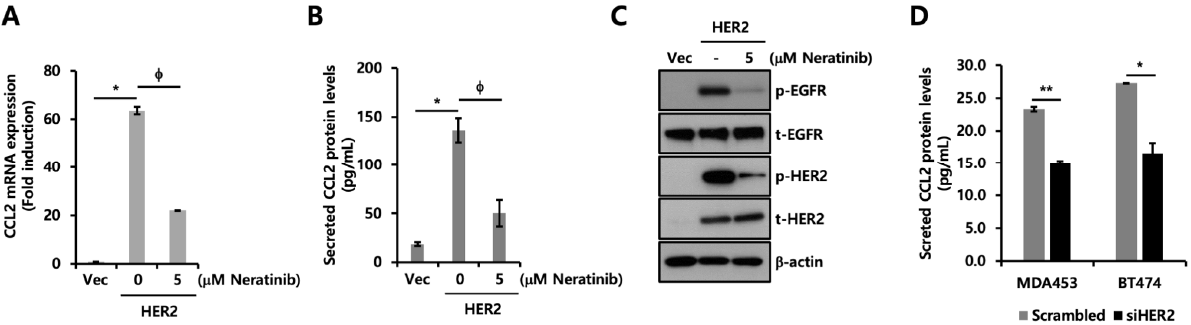
Figure 4. CCL2 expression is downregulated by neratinib. ( A , B ) Each cell line was treated with 5 μ M neratinib for 24 h. ( A ) Transcript levels of CCL2 were analyzed using RT-qPCR. Values were normalized to ACTB . ( B ) ELISA was performed using conditioned culture media of Vec and HER2- overexpressed MDA-MB231 cells. ( C ) Levels of protein expression were analyzed using Western blotting with indicated antibodies. β -actin was used as a loading control. ( D ) ELISA was performed using conditioned culture media of MDA453 and BT474 cells transfected with scrambled or HER2- specific siRNA. * p < 0.05; ** p < 0.01; φ p < 0.05.